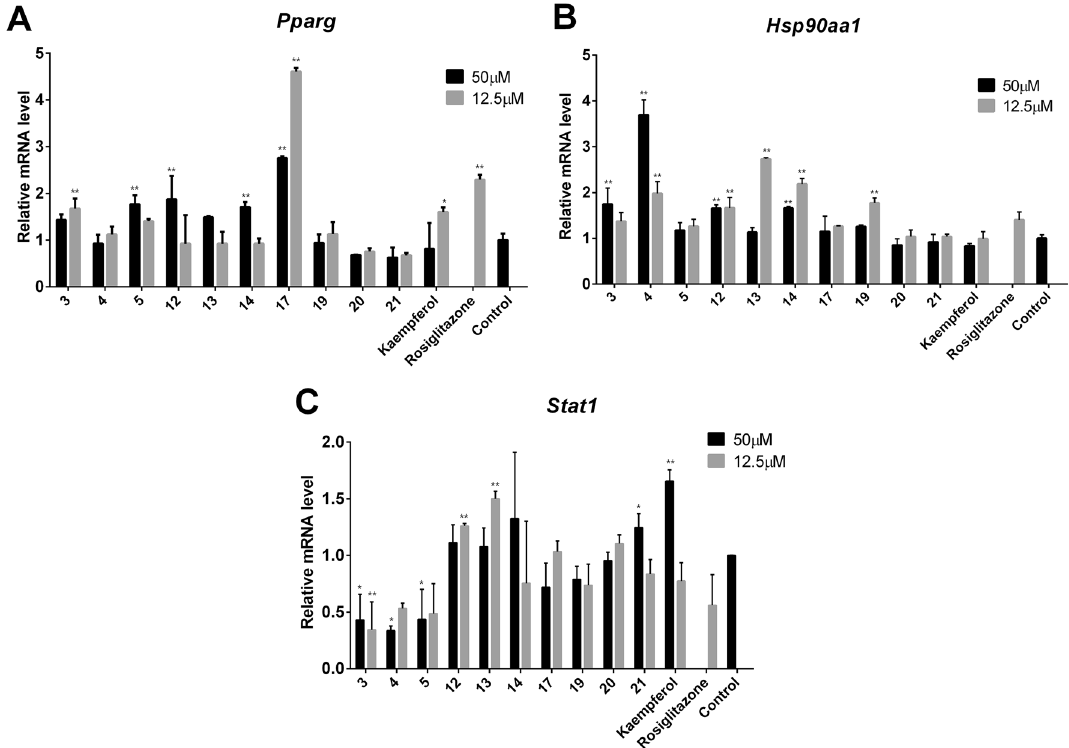
Figure 6. The mRNA levels of the key co-targets HSP90AA1, PPARG and STAT1 were adjusted by the flavonoids of SCST. ( A – C ) The relative mRNA levels of Pparg, Hsp90aa1 and Stat1 in each intervention group ( n = 3). Mean values ± SD are presented. ** P < 0.01 vs . the control group, * P < 0.05 vs . the control